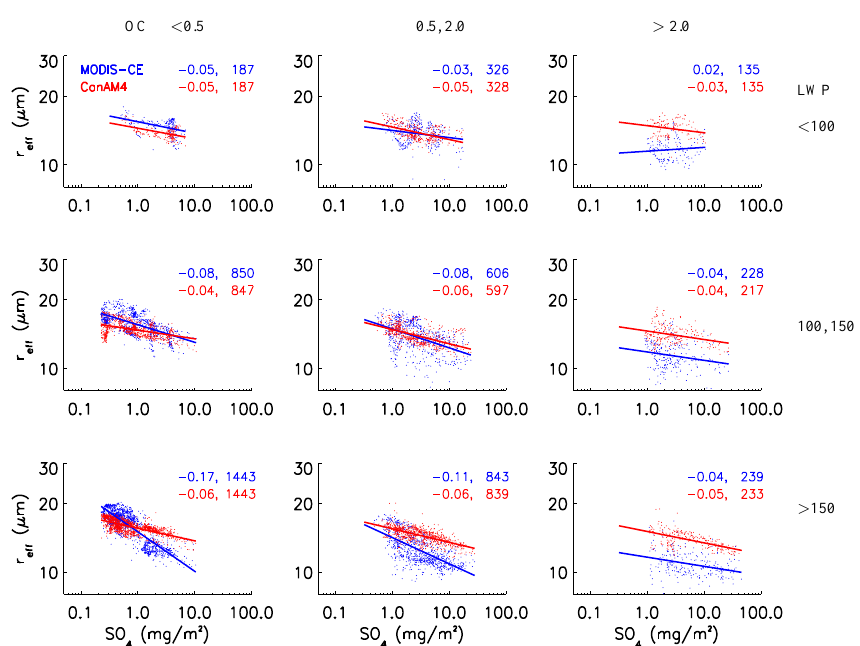
Fig. 4. Low (surface to 700hPa) cloud effective radius (in µm) from MODIS-CE (in blue) and CanAM4 (in red) versus sulphate (SO 4 ) Fig.4. Low(surfaceto700hPa)cloudeffectiveradius(in µ m)fromMODIS-CE(inblue)andCanAM4(inred) concentrations in JJA. The data were stratified for 3 categories of liquid water path (LWP, in g/m 2 ), and 3 categories of hydrophylic organic versussulphate(SO 4 )concentrationsinJJA.Thedatawerestratifiedfor3categoriesofliquidwaterpath(LWP, carbon (OC, in mg/m 2 ). The slopes and numbers from linear regression are also marked in the plots. in g/m 2 ), and 3 categories of hydrophylic organic carbon (OC, in mg/m 2 ). The slope from linear regression are also marked in the plots.